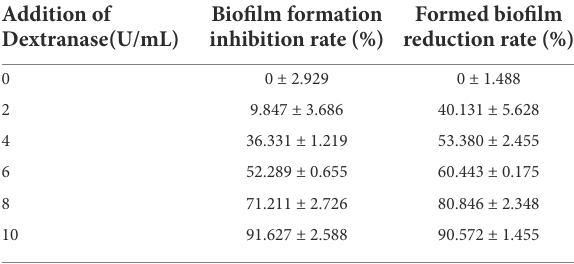
TABLE 5 The proportion of the productions of hydrolyzed